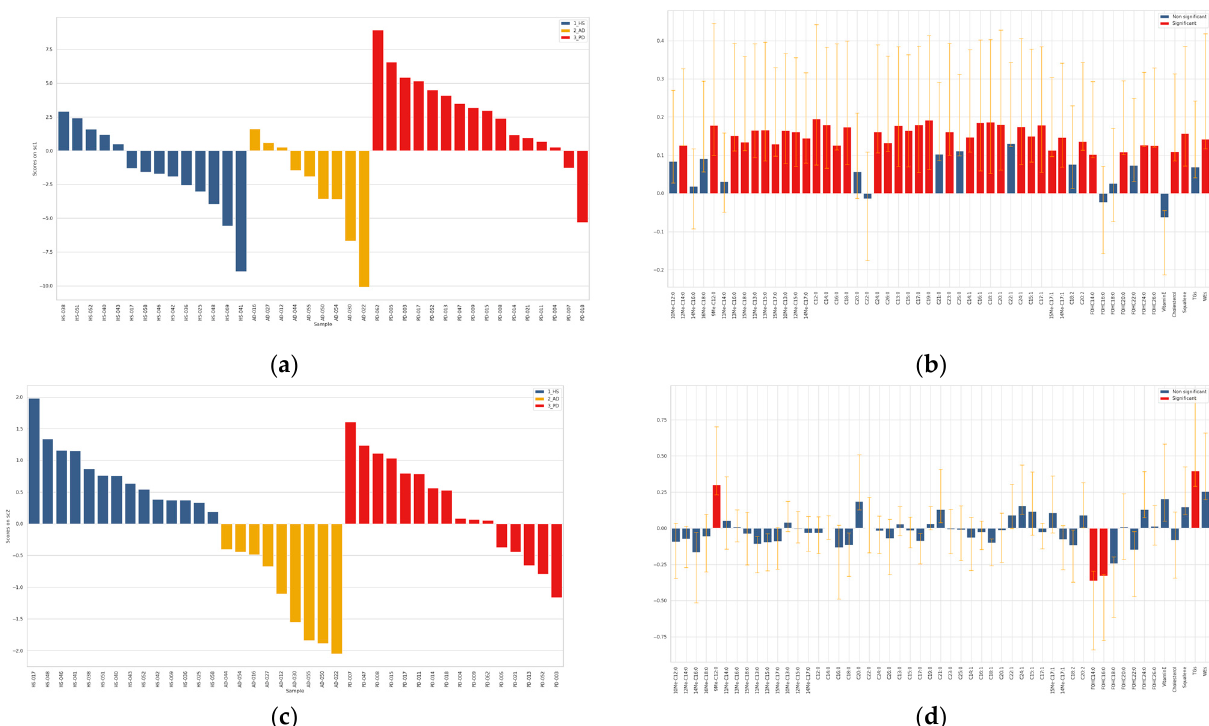
Figure 3. ASCA analysis on the effect matrix (absolute amounts, µ g) for NDD conditions investigated in sebum from male (M) subjects. Panels ( a , c ) report the SC1 and SC2 scores, respectively, after projection of the residuals onto the space spanned by the significant principal component (PC) 1 and PC2; legend: blue = HS; yellow = AD; red = PD. Panels ( b , d ) display the variable loadings on SC1 and SC2, respectively, together with their confidence interval (red and blue bars indicate significantly and not significantly contributing descriptors,